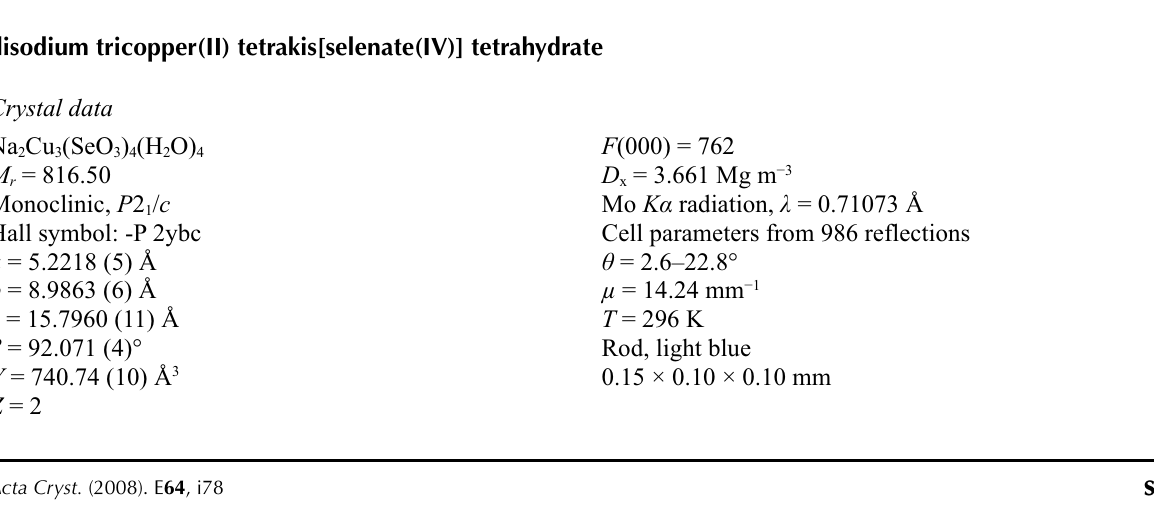
Schematic representation of the formation of the anionic framework structure of (I). ( a ): The wavy layer built from an edge-sharing linear chain by corner-sharing 4-membered rings and ladders by edge-sharing 8-membered rings; ( b ): The wavy layers intersecting each other with an approximate angle of 110° to the entire three-dimensional open-framework. (Black spheres: Cu atoms; white spheres: Se